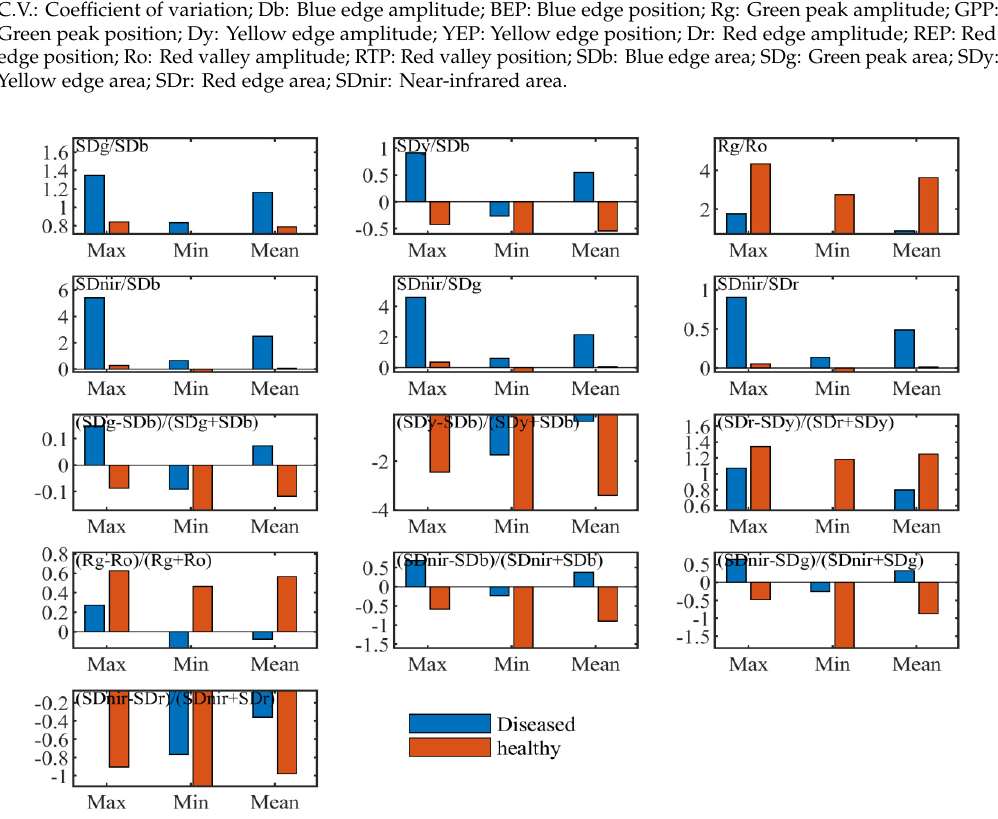
Figure 3. Descriptive statistics of some ratio and normalized indices with spectral amplitude and area parameters.